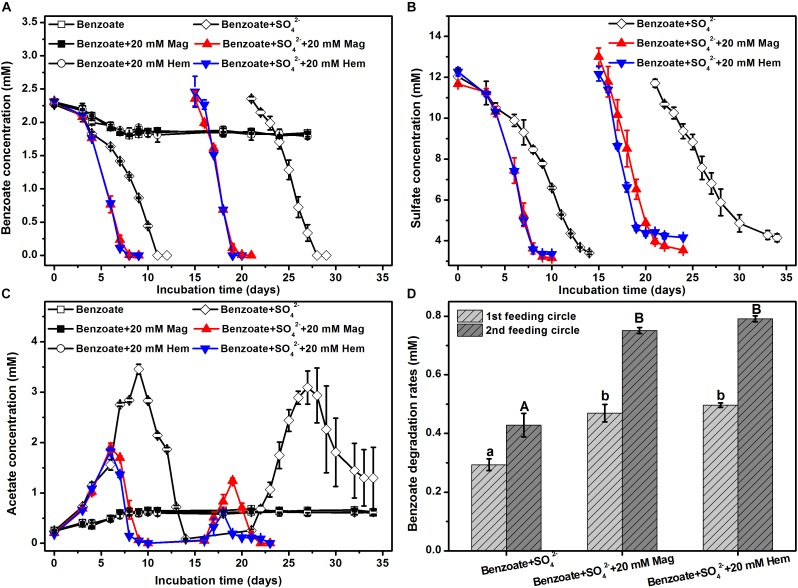
Sulfate-dependent benzoate degradation in the anaerobic incubation of sediments from Pearl River Estuary in the presence and absence of conductive iron oxides: (A) benzoate degradation; (B) sulfate reduction; (C) acetate concentration; (D) benzoate degradation rates (calculated from the phase with fastest benzoate degradation). Two feeding cycles were included. The lowercases and capitals letters indicate the significant differences among three treatments in the first and the second feeding cycle, respectively. Mag and Hem denote magnetite and hematite, respectively.